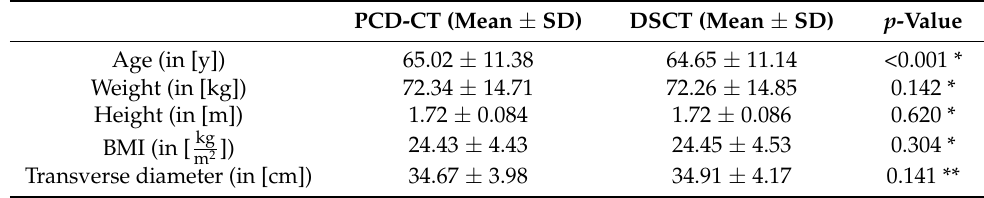
Table 2. Patient characteristics.